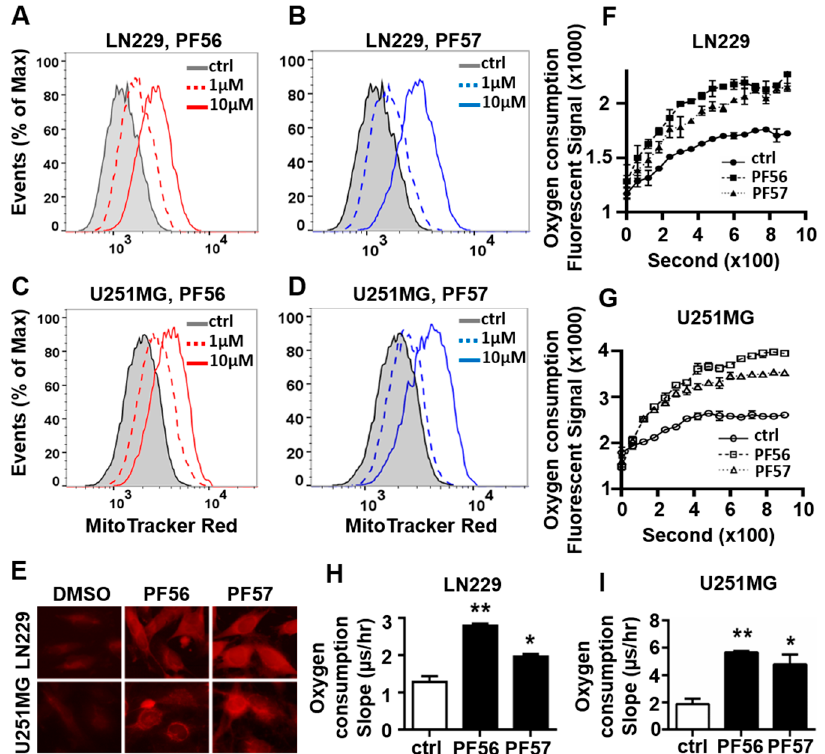
Figure 4. FAK inhibition increases MitoTracker uptake into mitochondria and oxygen consumption in LN229 and U251MG cells. ( A – D ) Flow cytometry analysis of MitoTracker stained cells treated with PF573228 (PF57) or PF562271 (PF56) for 16 h at 1 and 10 μ M, respectively. ( E ) Representative immunofluorescent images of the MitoTracker labeled LN229 and U251MG in the presence of PF56 or PF57 (400×). ( F , G ) Oxygen consumption curve in cells treated with PF56 or PF57 at 10 μ M. ( H , I ) Cellular oxygen consumption rate (slope) calculated based on the oxygen consumption curve in cells treated with 10 μ M FAK inhibitors PF56 or PF57. All experiments were repeated at least three times. Data are represented as mean ± SE, * p < 0.05, ** p < 0.01.